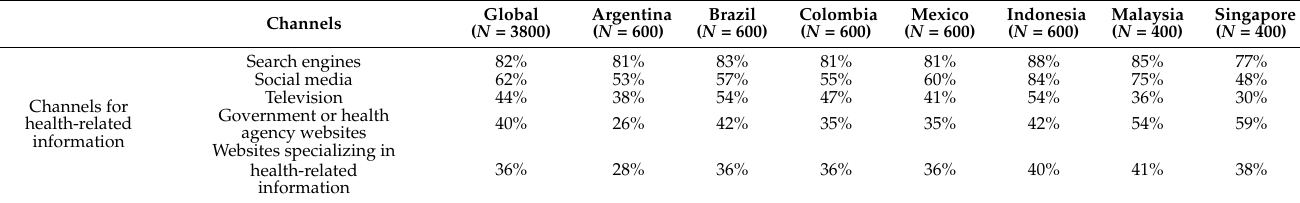
Table 5. Top 5 trusted channels for health-related information.